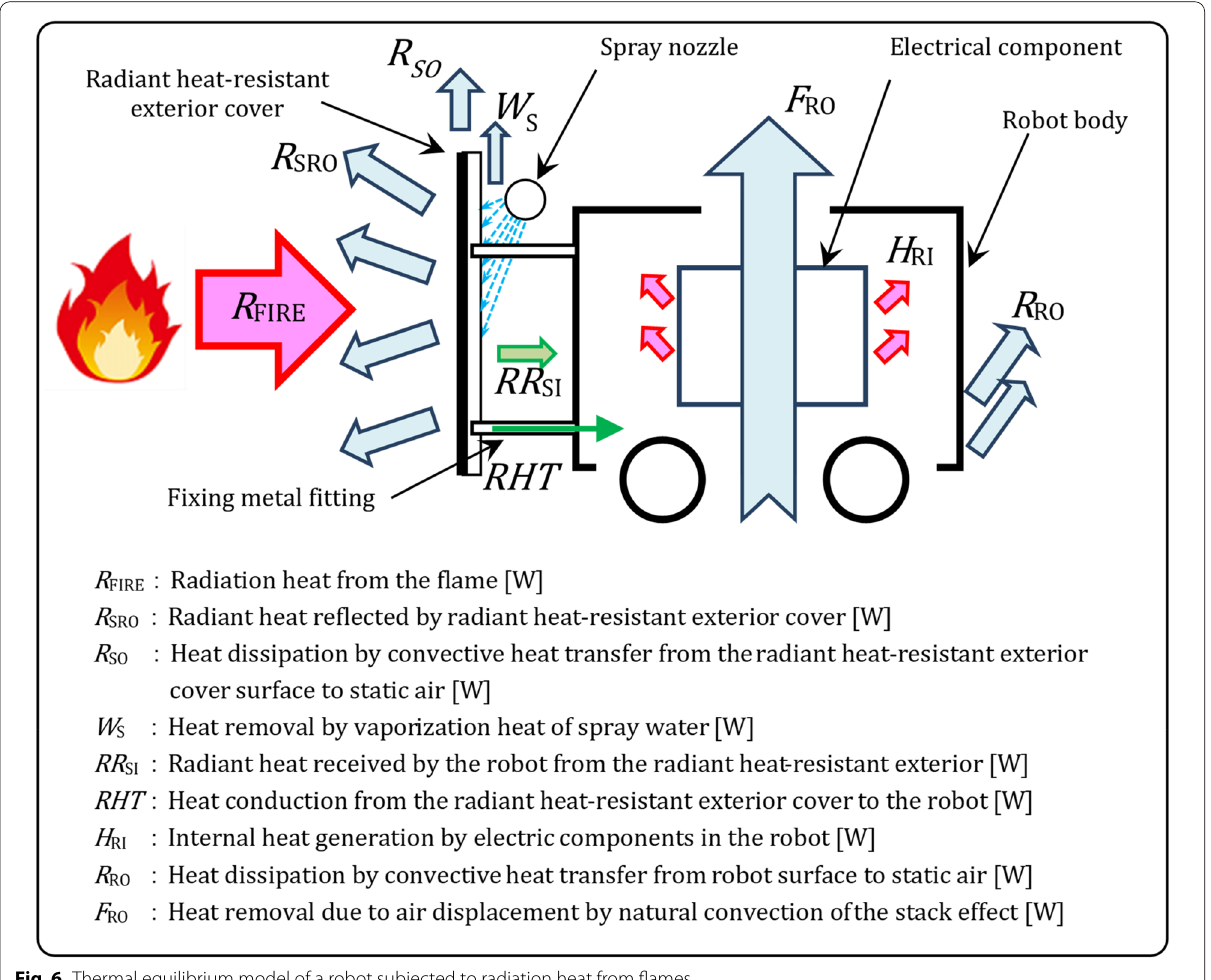
Fig. 6 Thermal equilibrium model of a robot subjected to radiation heat from